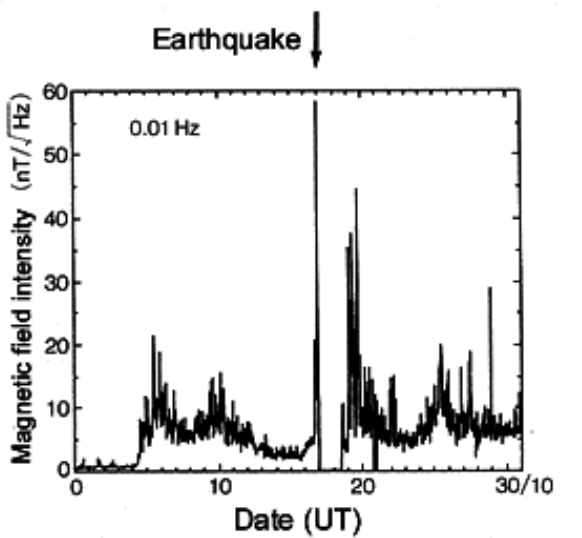
Figure 1. Temporal evolution of geomagnetic variation for the Loma Prieta earthquake (f=0.01Hz) (after Fraser-Smith et al.,